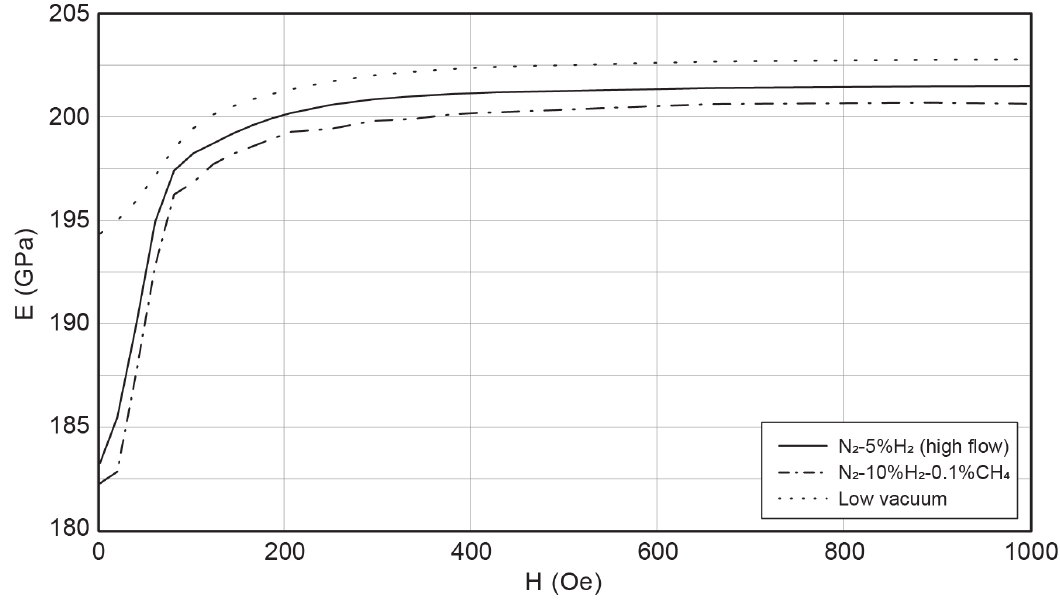
Figure 12. ∆ E-effect of specimens sintered at 1325 °C for 12 h in different atmospheres. Table 6. ∆ E-effect as a function of atmosphere used in the samples sintered at 1325 °C for 12